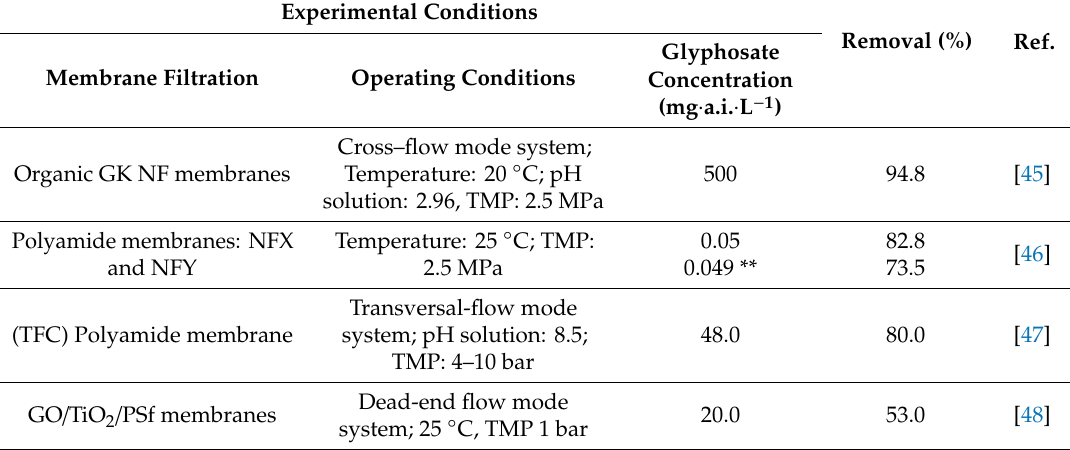
Table 3. Removal of glyphosate from water polluted by membrane filtration. Experimental